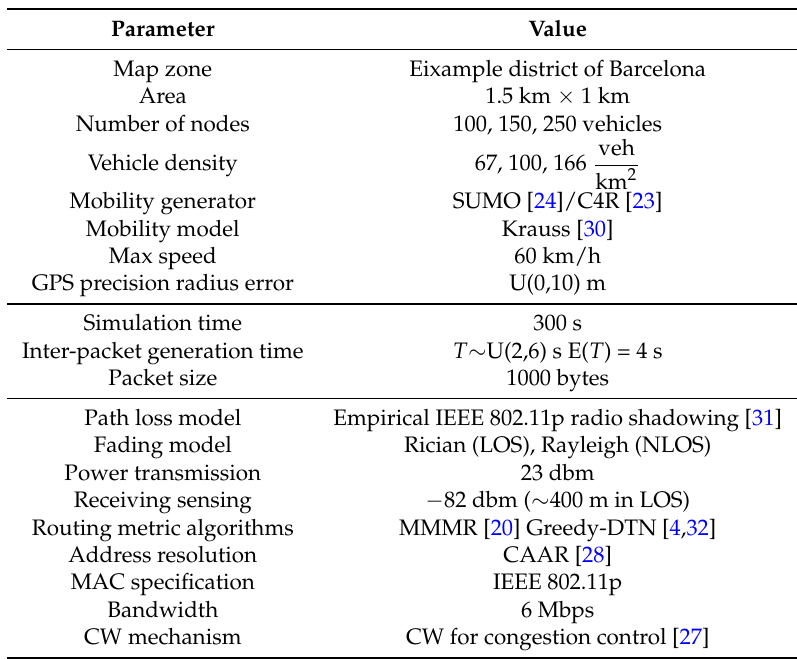
Table 1. Simulation